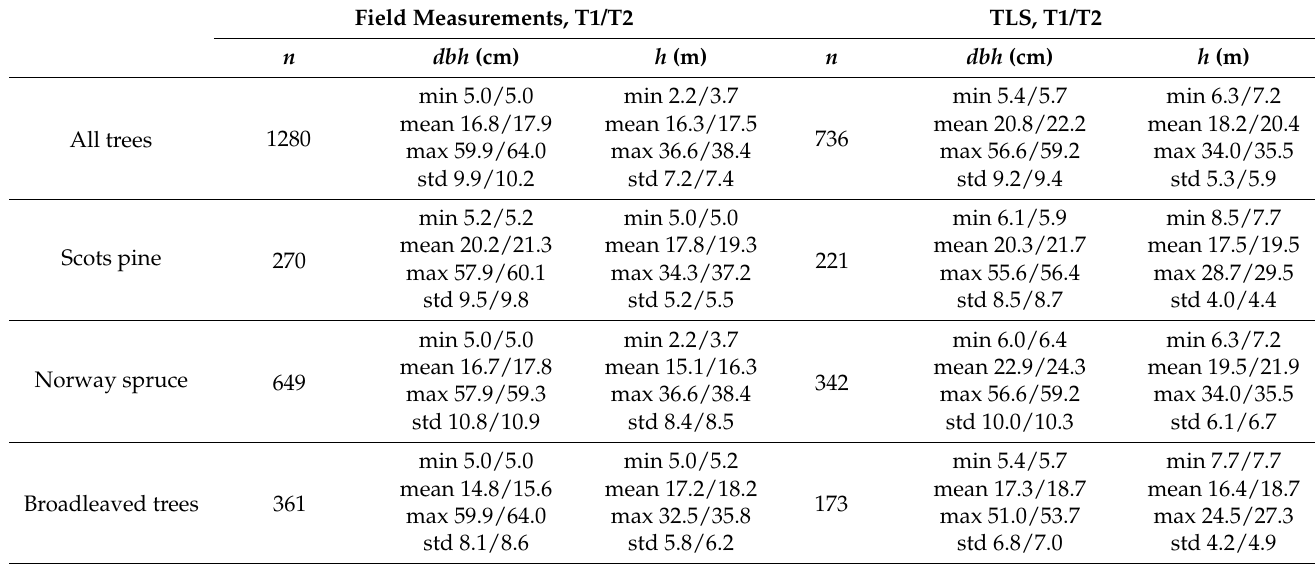
Table 1. Descriptive statistics of diameter at breast height ( dbh ) and height ( h ) of the trees that were measured in the field and derived from terrestrial laser scanning (TLS) point clouds both at the beginning (2014, T1) and at the end of the monitoring period (2019, T2) by tree species. Scots pine refers to Pinus sylvestris (L.), Norway spruce refers to Picea abies (L.) H. Karst., and broadleaved trees refers to birches ( Betula sp. ) and European aspen ( Populus tremula